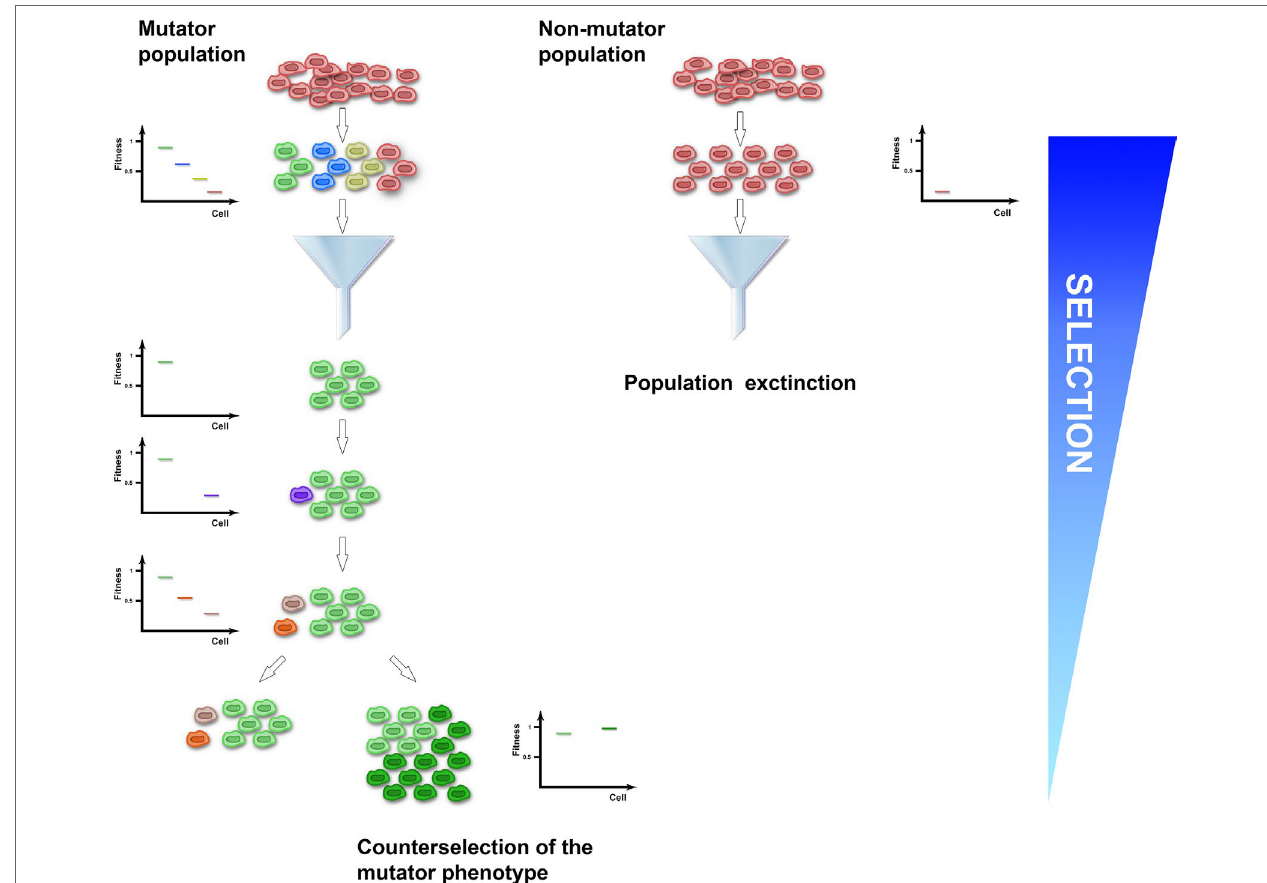
FIGURE 1 | The mutator population (left) experiences enhanced genome instability and acquires cell-to-cell heterogeneity, while the non-mutator population (right) expands clonally. Upon application of selection, the mutator-induced phenotypic variation increases the probability of the population to have cells with a selective advantage (green cells) that could be fixed. Conversely, the clonal non-mutator population has higher probability of becoming extinct (red cells). Once adaptive mutations have been fixed and the population reaches a local optimum, acquisition of additional variation is detrimental and selected against (purple, orange, and grey cells). To increase adaptation in non-selective conditions, the mutator population can evolve a suppressor of the genome instability phenotype (dark green